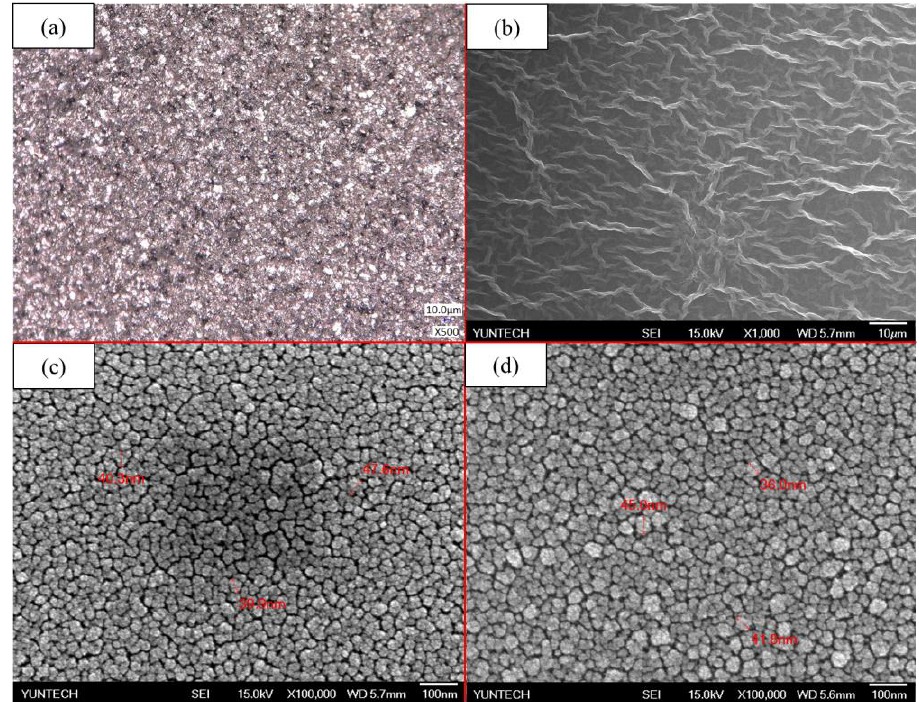
Figure 5. Field-emission scanning electron microscope (FE-SEM) images of different membranes: ( a ) silver, ( b ) GO, ( c ) zinc oxide (ZnO), and ( d ) aluminum-doped zinc oxide (AZO).